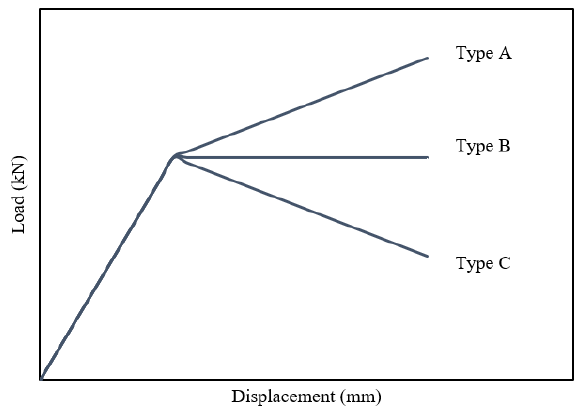
Figure 5. Varying schematic load–displacement behaviour under pushout loads.